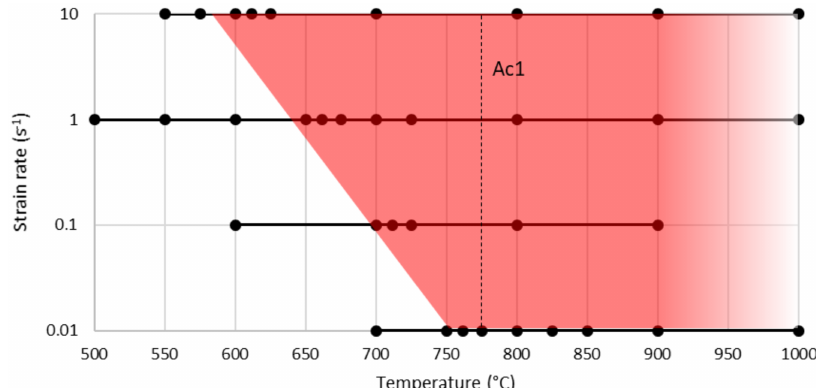
Figure 4. Testing schedule and visible LME in red for a variation of strain rates and temperatures. The dots mark the exact testing